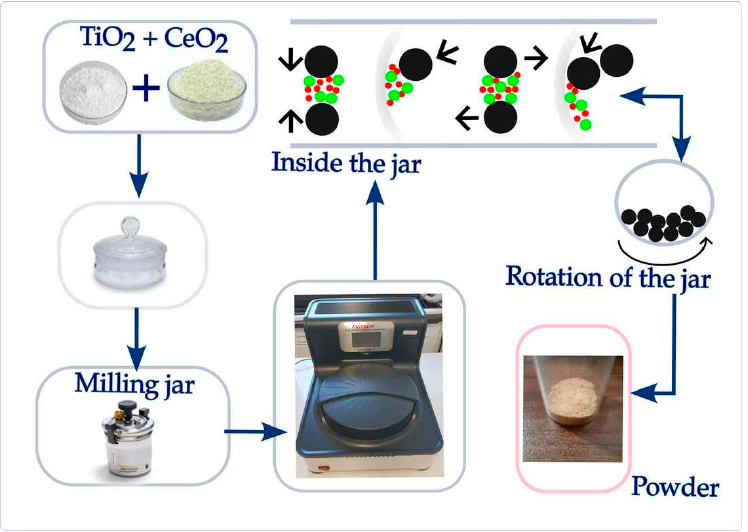
Figure 1. Schematic illustration of the mechanochemical procedure. Also shown are the processes that occur during high ball milling inside the jar: collision, impact, shear, and friction.